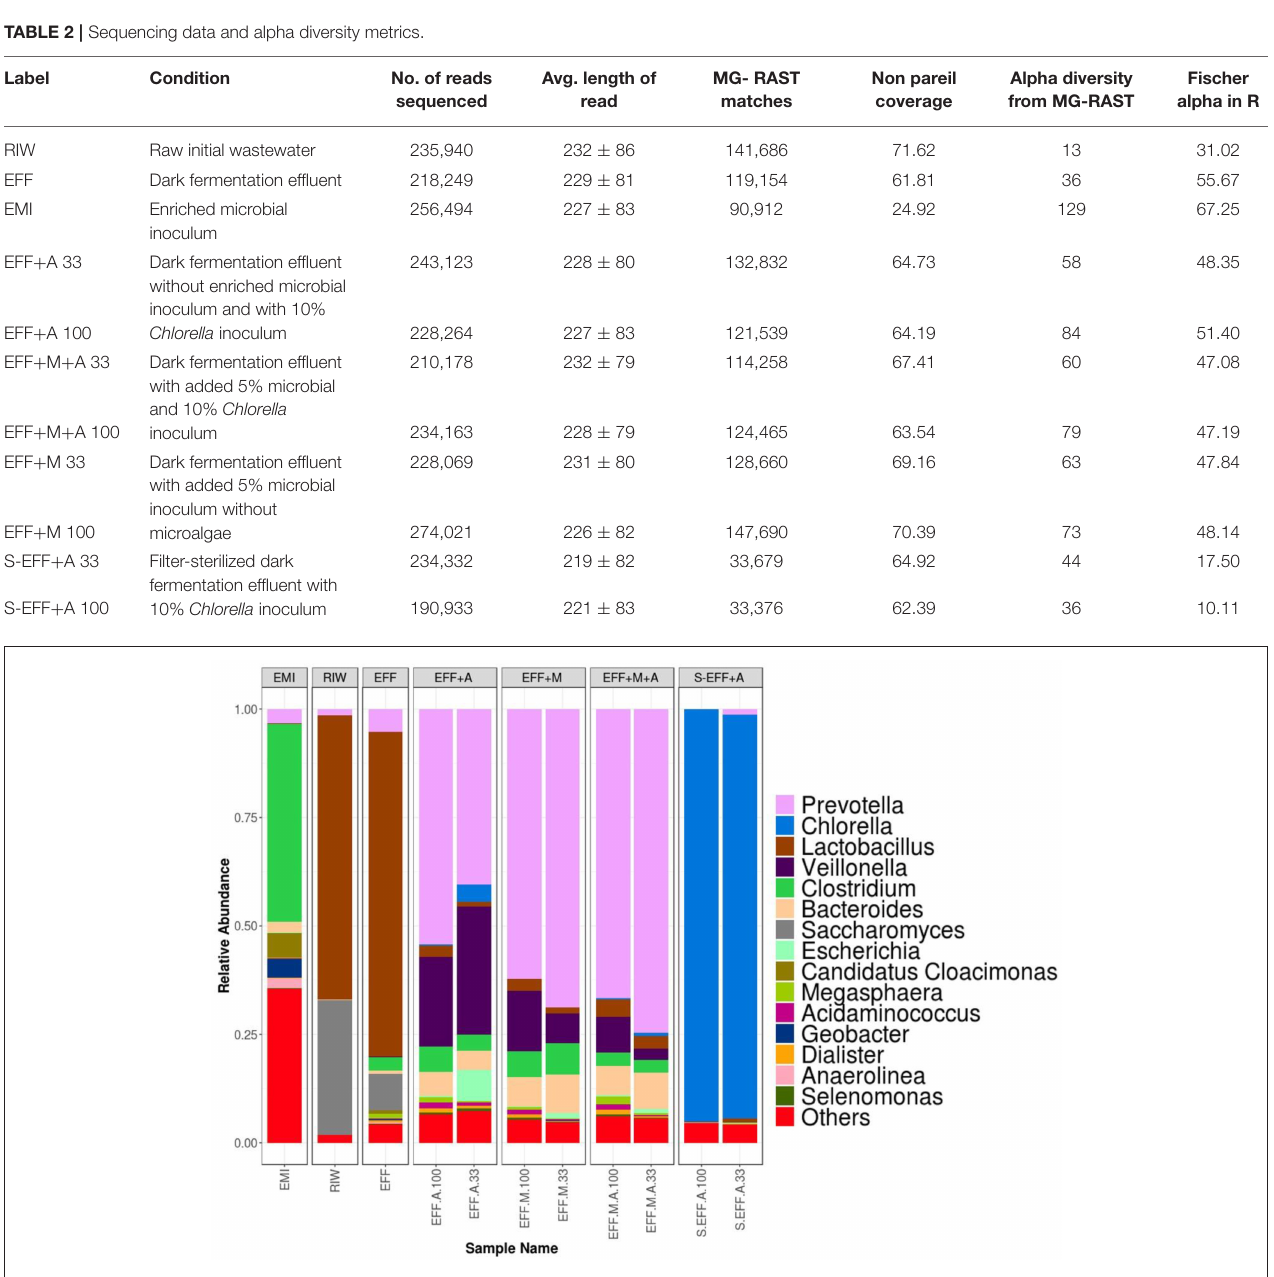
FIGURE 4 | Taxonomic profiles for all samples at the genus level. Enriched microbial inoculum (EMI) has a different profile of microbial genera compared to both the raw initial wastewater (RIW) and dark fermented wastewater (EFF). However, during photo-fermentation all the samples have a very similar profile and abundance of genera. Higher Ch. vulgaris abundance is seen in diluted samples compared to undiluted samples. This correlates well with cell count assays. The top 15 genera are shown below.